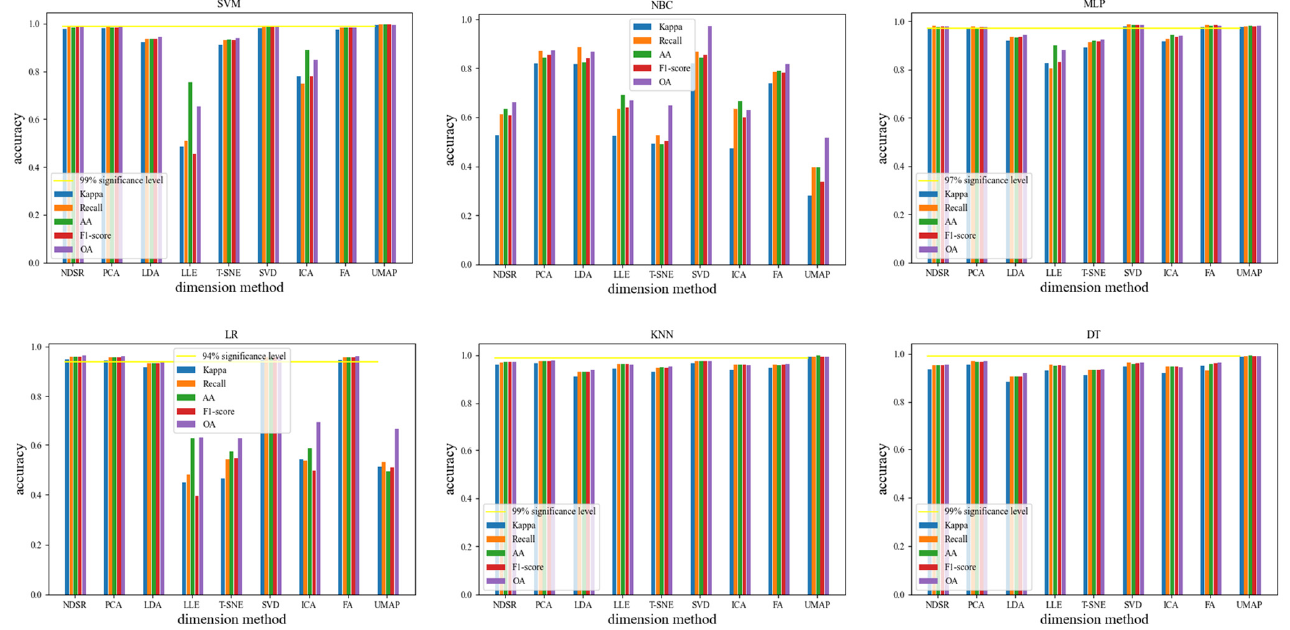
Figure 7. Comparison chart of overall classification accuracy of different dimensionality reduction methods.